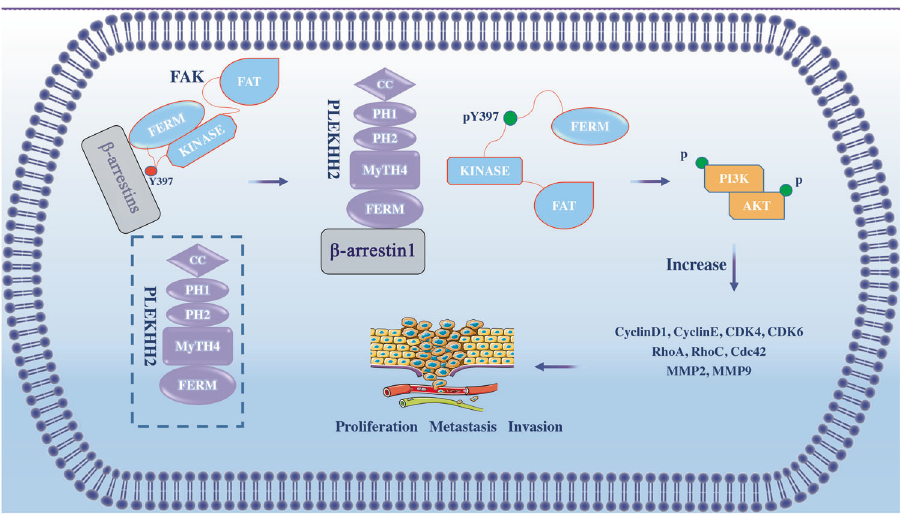
Fig. 8 A model depicting the proposed mechanism of PLEKHH2. Schematic model for the regulation of FAK/PI3K/AKT phosphorylation activity by PLEKHH2 in nonsmall cell lung cancer using Figdraw (www. fi